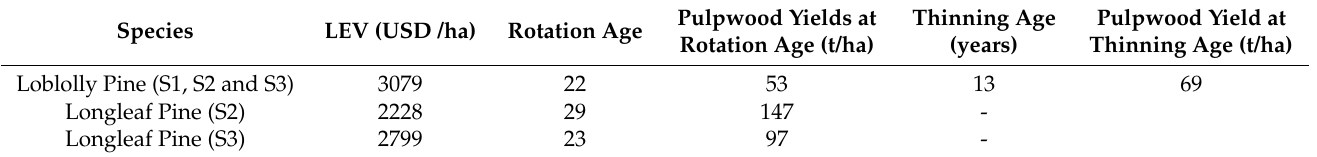
Figure 4. Distribution of pulpwood volume by stand age for loblolly and longleaf pine stands. Table 3. Land expectation value (LEV), optimal rotation age (years), pulpwood yield at the optimal rotation age, thinning age, and pulpwood yield at thinning age for loblolly and longleaf pines.